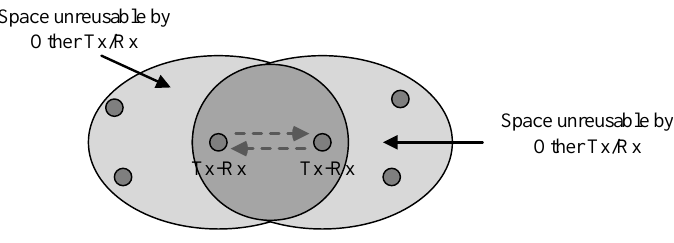
Figure 11. Full duplex transmission spatial